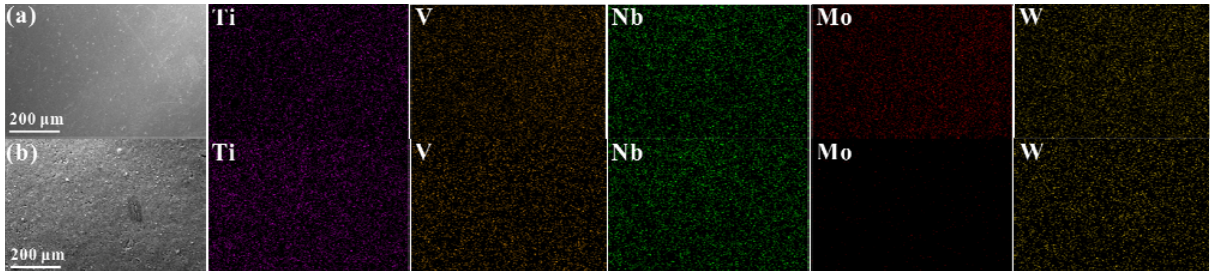
Fig. 7 SEM images and corresponding EDS element distributions of (TiVNbMoW)C 4.375 after heat treatment at (a) 400 ℃ and (b) 800 ℃ .